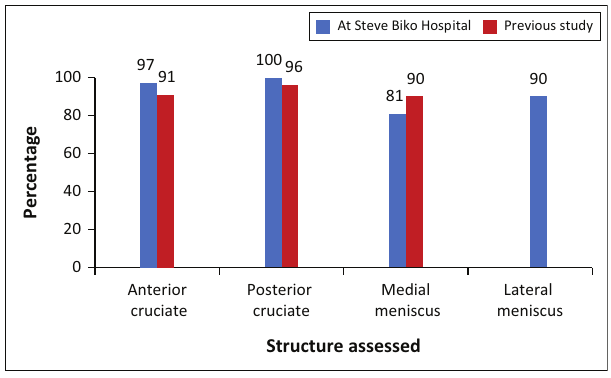
FIGURE 3: Kappa values for each